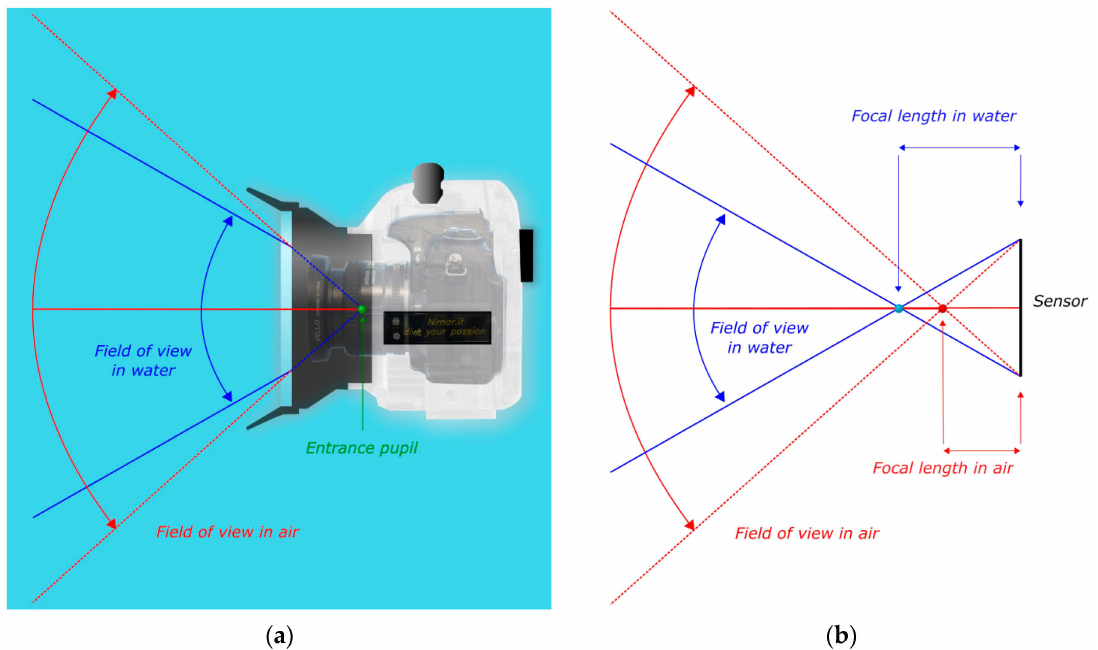
Figure 2. Effect of flat port—Reduction of FOV. ( a ) Optical rays (in red) from the camera when pass through the planar boundary are bent towards the normal to the flat surface, narrowing the field of view; ( b ) This phenomenon can be regarded as an increase of the nominal focal